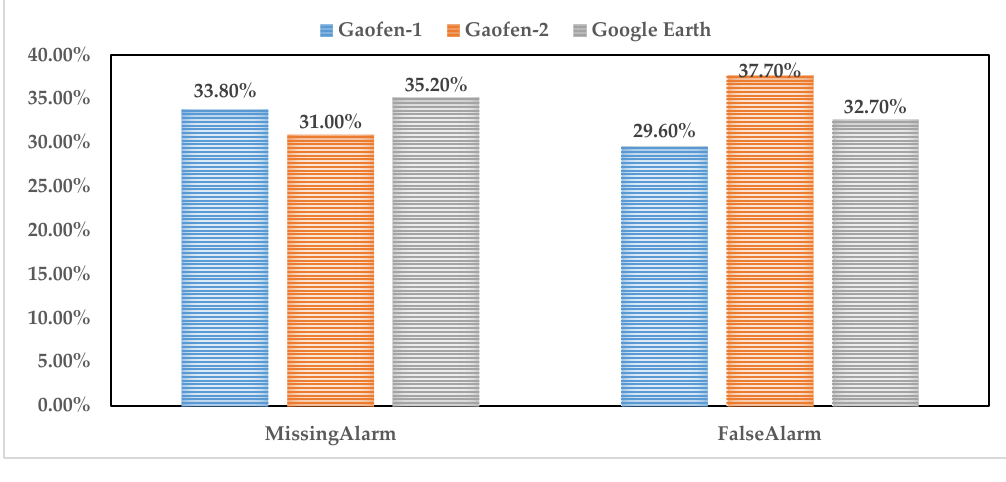
Figure 11. MissingAlarm and FalseAlarm based on objects.